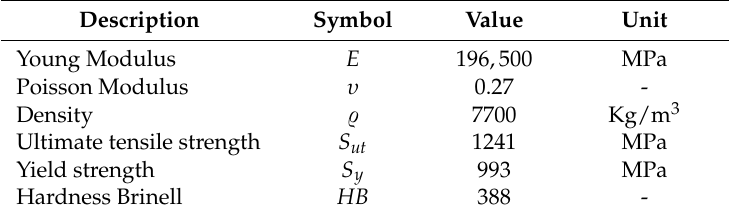
Figure 11. The finite element model of the recirculating mechanism. Table 2. The 17–4 PH material